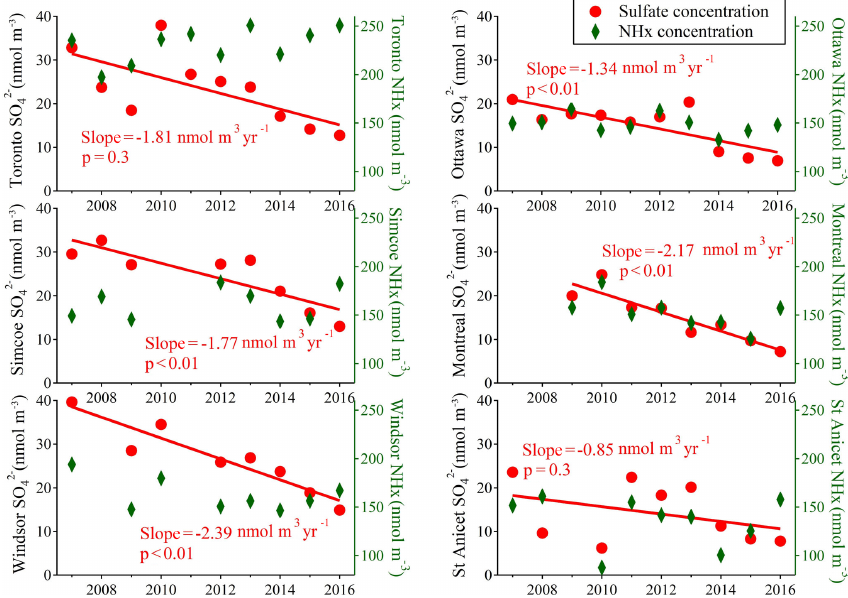
Figure 7. 10-year trends of summertime average concentrations of sulfate and NH x at each site. Linear regressions of sulfate were illustrated on each graph to represent the reduction of particulate sulfate from 2007 to